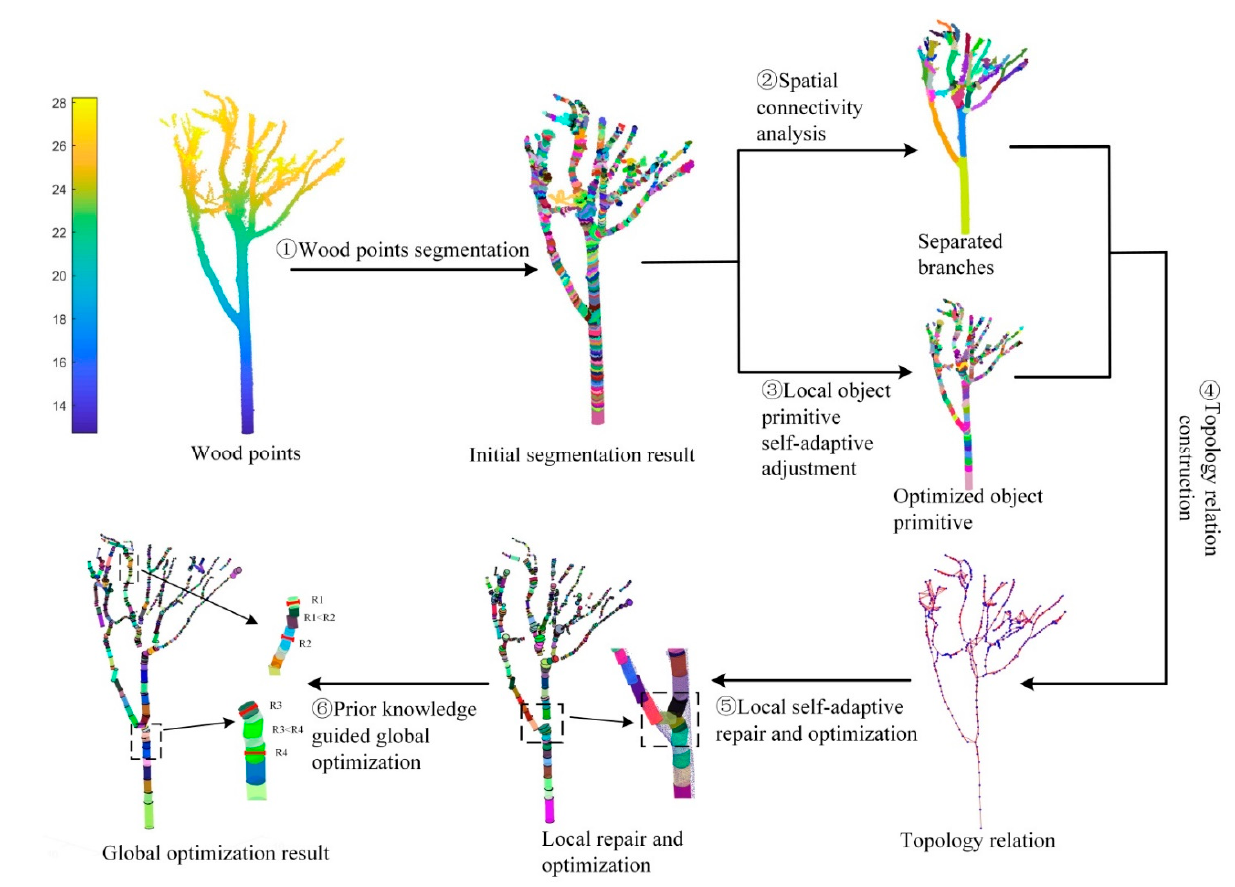
Figure 1. Flowchart of the proposed